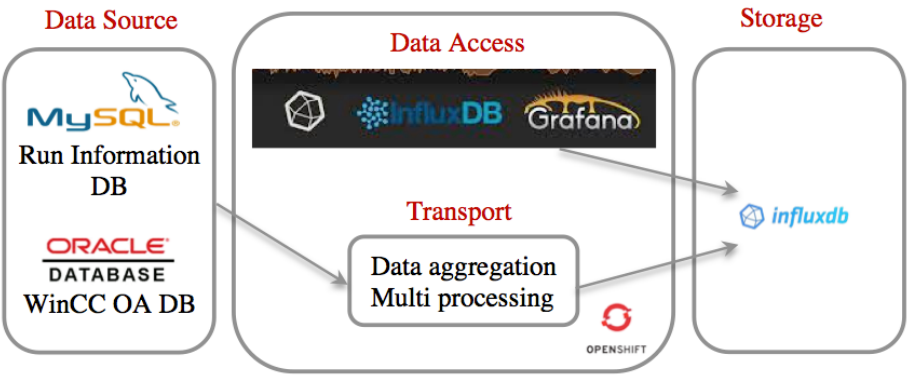
Fig. 1. DCS monitoring data